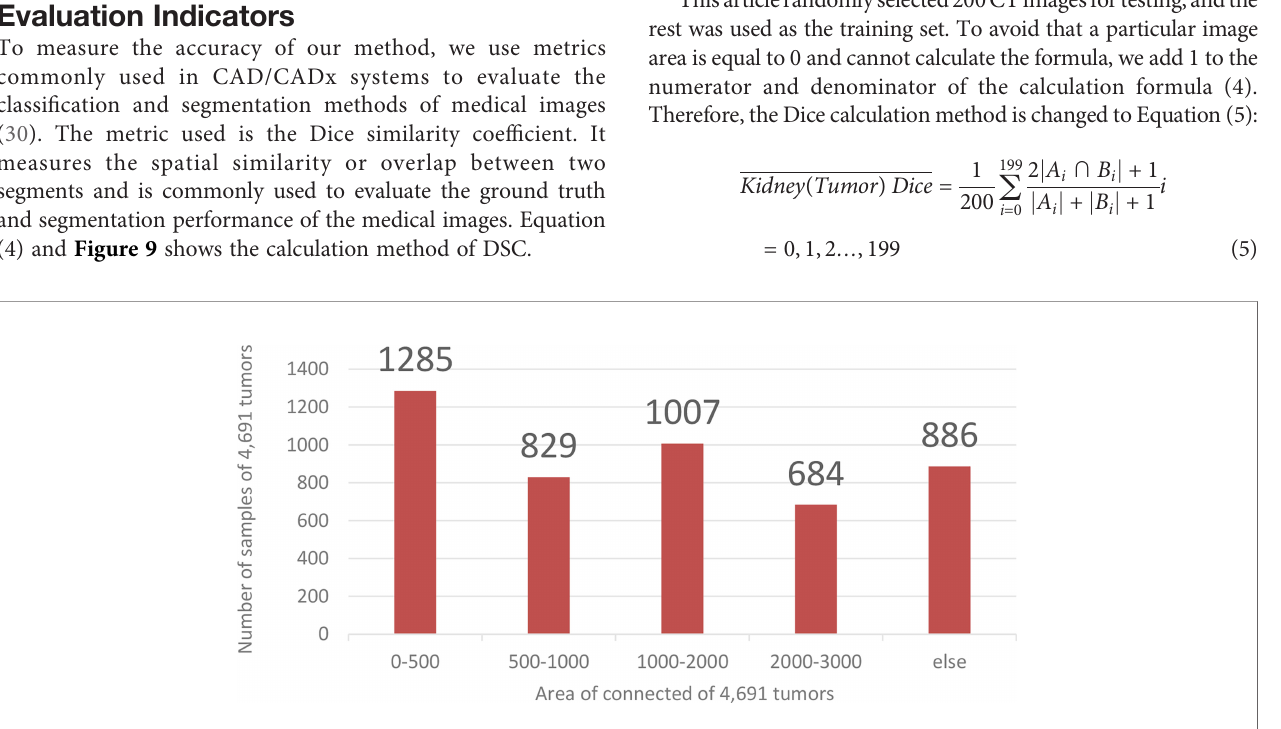
FIGURE 7 | Training data distribution. The abscissa is the Area of connection of 4,691 tumors, and the ordinate is the number of samples of 4,691 tumors.